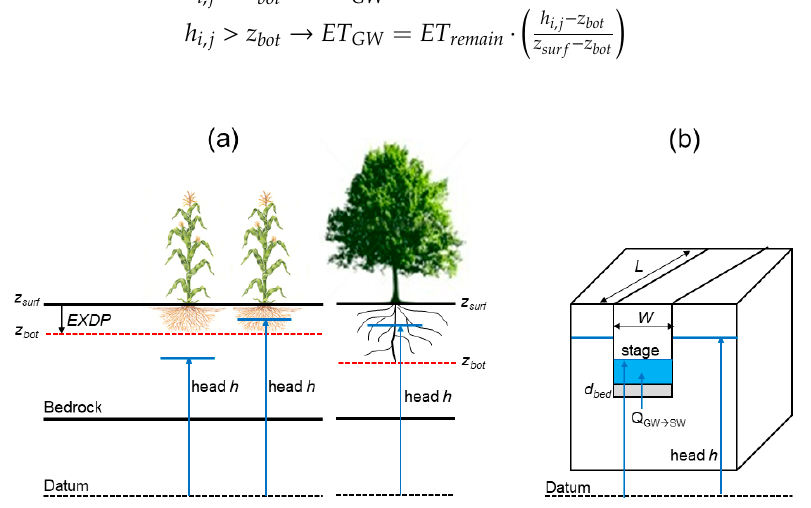
Figure 2. Variable depictions and cross-section schematics for ( a ) groundwater Evapotranspiration (ET) calculations and ( b ) groundwater–surface water exchange.